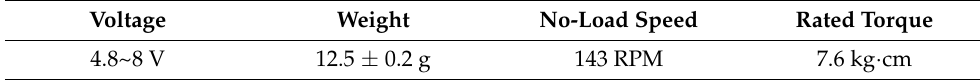
Table 3. Performance parameter table of